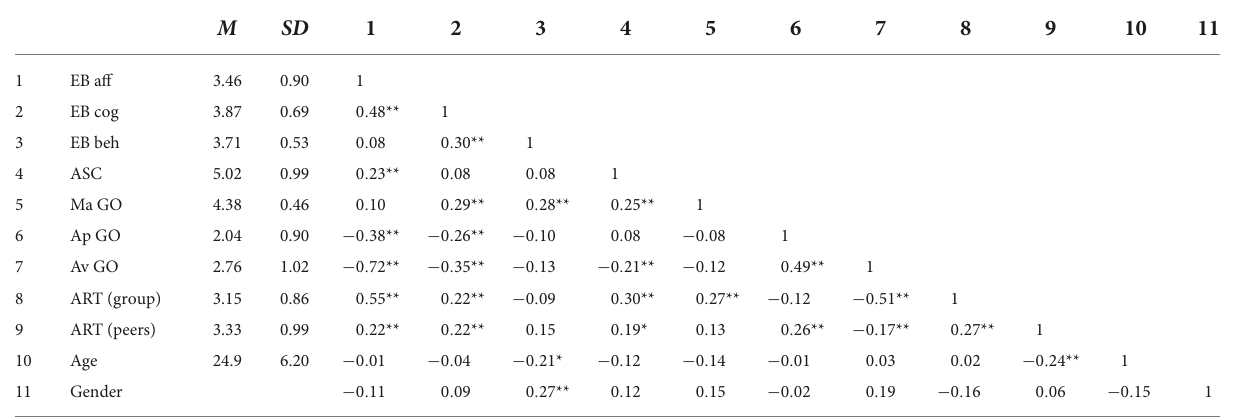
TABLE 1 Means, standard deviations, and bivariate correlation of all